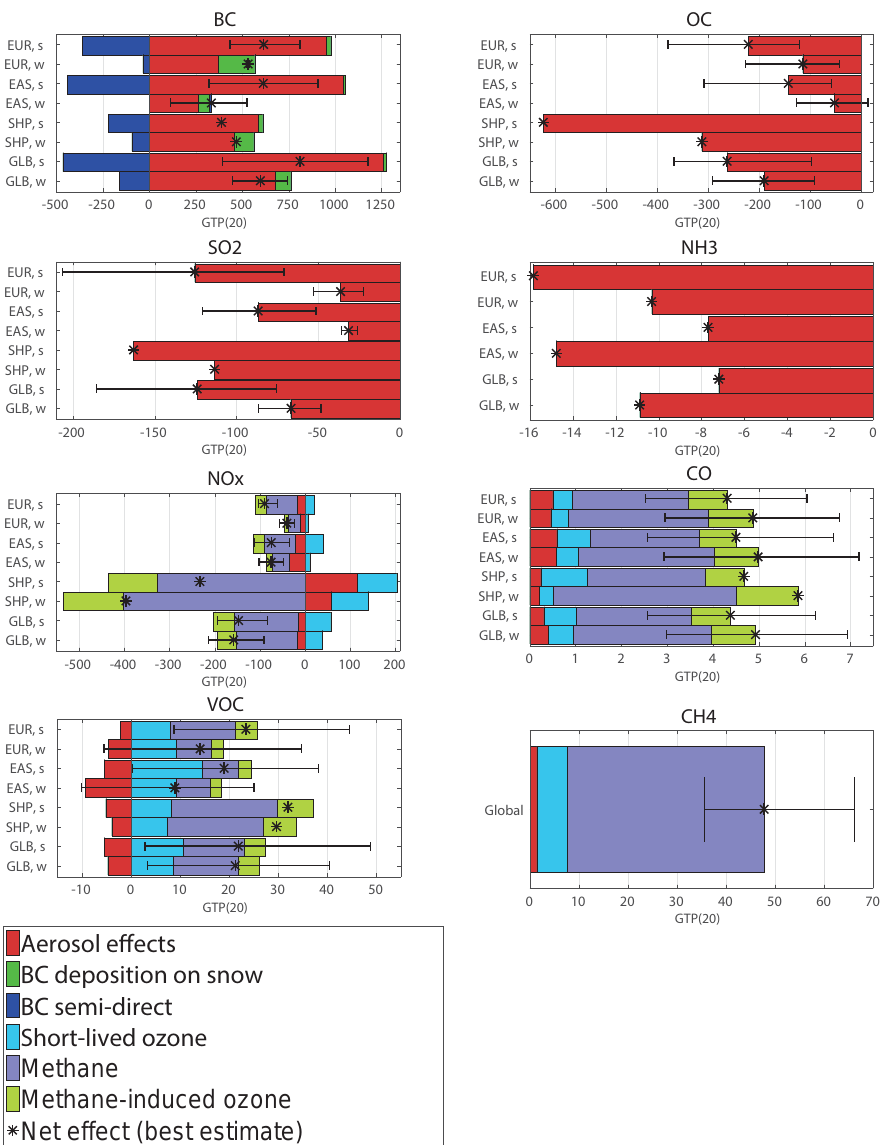
Figure 2. GTP(20) values for the species, for all regions and seasons, decomposed by processes. The regions included are Europe (EUR), East Asia (EAS), shipping (SHP), and global (GLB), all for both NH summer (s), May–October, and NH winter (w), November–April. How the best estimate of the net effect is calculated is given in Sect. 2.1. The uncertainty bars show the range across models, which is not given for shipping as the best estimate is based on only two models for that sector. For CH 4 emissions, the ozone effect is formally classified as short-lived ozone, but the perturbation timescale is the same as for the methane-induced ozone effect.